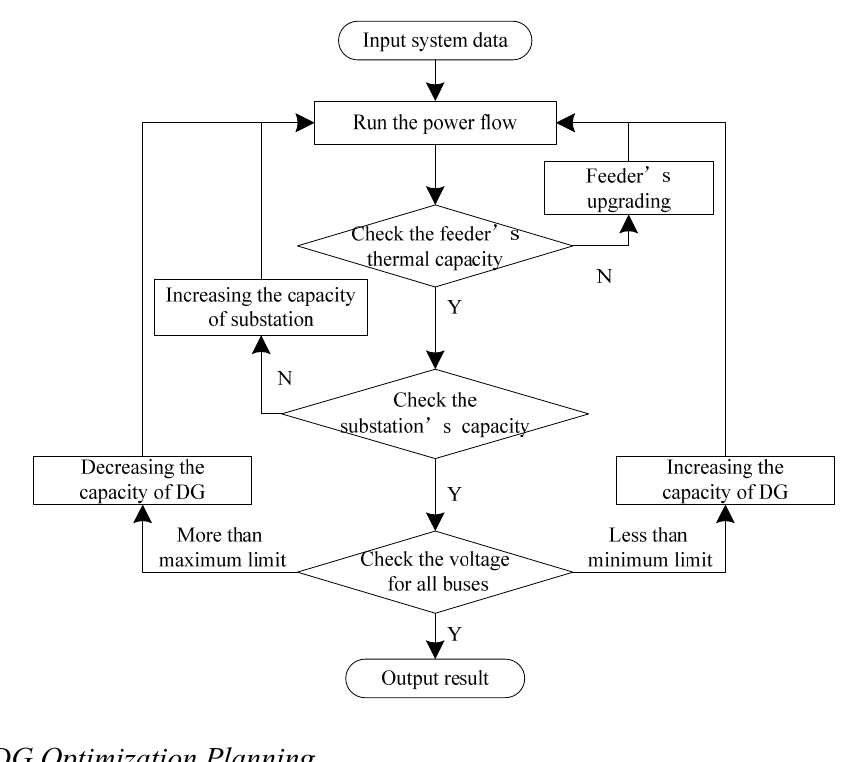
Figure 6. The flowchart of the progress of constraints.